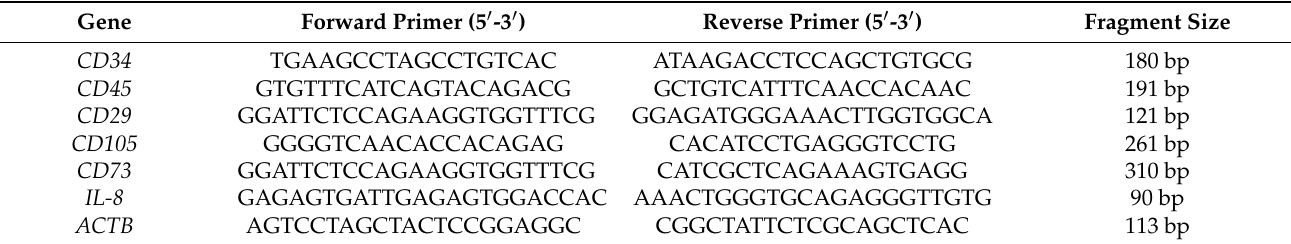
Table 3. List of forward and reverse primes used from